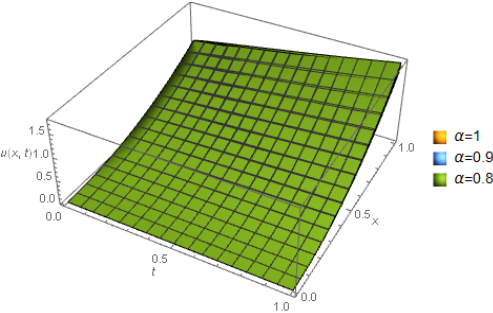
Figure 2:3D approximate Solution of Figure 1:3D exact Solution of example1 example1 with (cid:11) = 1 Figure 2:3D approximate Solution of with (cid:11) = 1 Figure 1:3D exact Solution of example1 Figure 2. 3D approximate Solution of Example 1 with α = 1. example1 with (cid:11) = 1 with (cid:11) = 1 Figure 3:3D Solutions of example1 with di⁄erent Figure4: Absolute error of example1 at (cid:11) = 1 values of (cid:11)